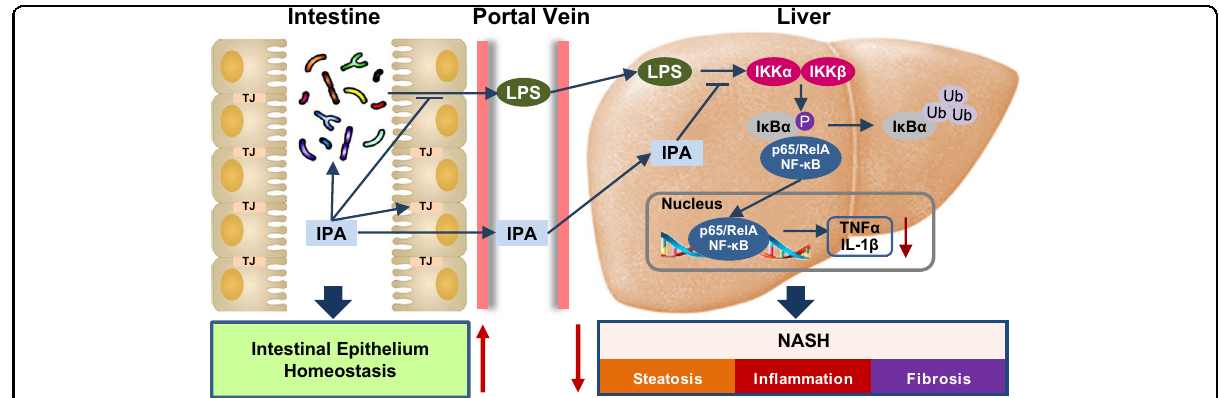
Fig. 7 The proposed model for the bene fi cial effects of IPA on the gut microbiota and steatohepatitis. Administration of IPA improves microbiota dysbiosis, increases tight junction proteins in the gut, and reduces the production of endotoxin. Moreover, IPA attenuates NASH likely through repressing endotoxin-induced activation of NF- κ B signaling and production of proin fl ammatory cytokines, suggesting cross-talk between the gut microbiota and